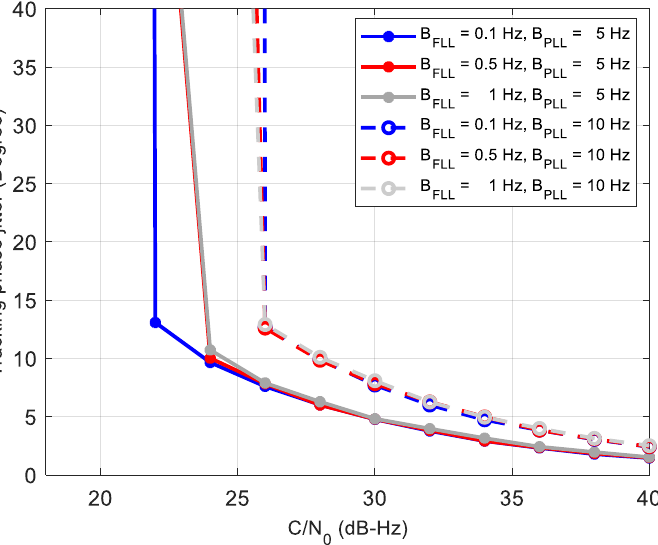
Figure 12. Phase jitter using the 2nd-order FLL assisted 3rd-order Phase-locked loop (PLL).